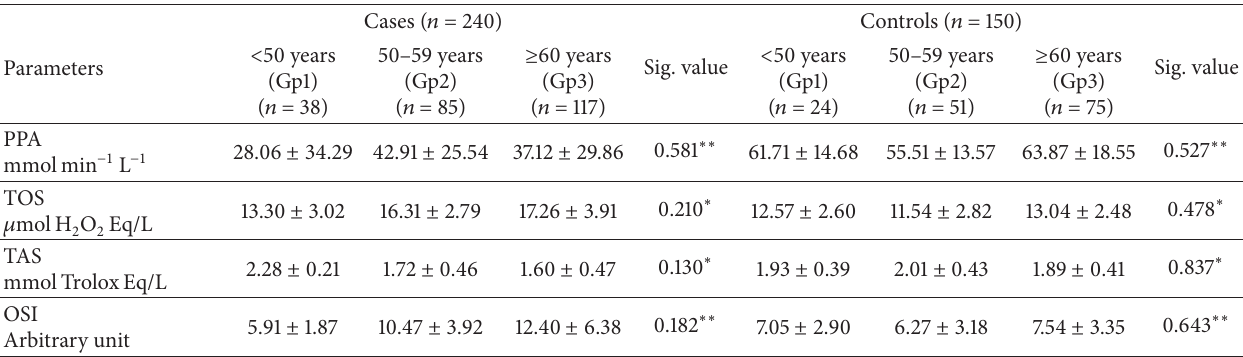
Table 3: Representation of PPA, TOS, TAS, and OSI in different age groups of cases and controls.